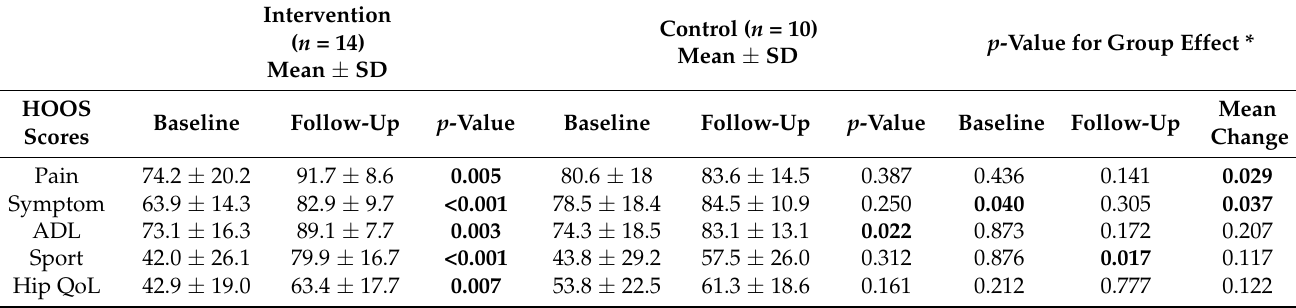
Table 3. Comparisons of HOOS scores within groups and between